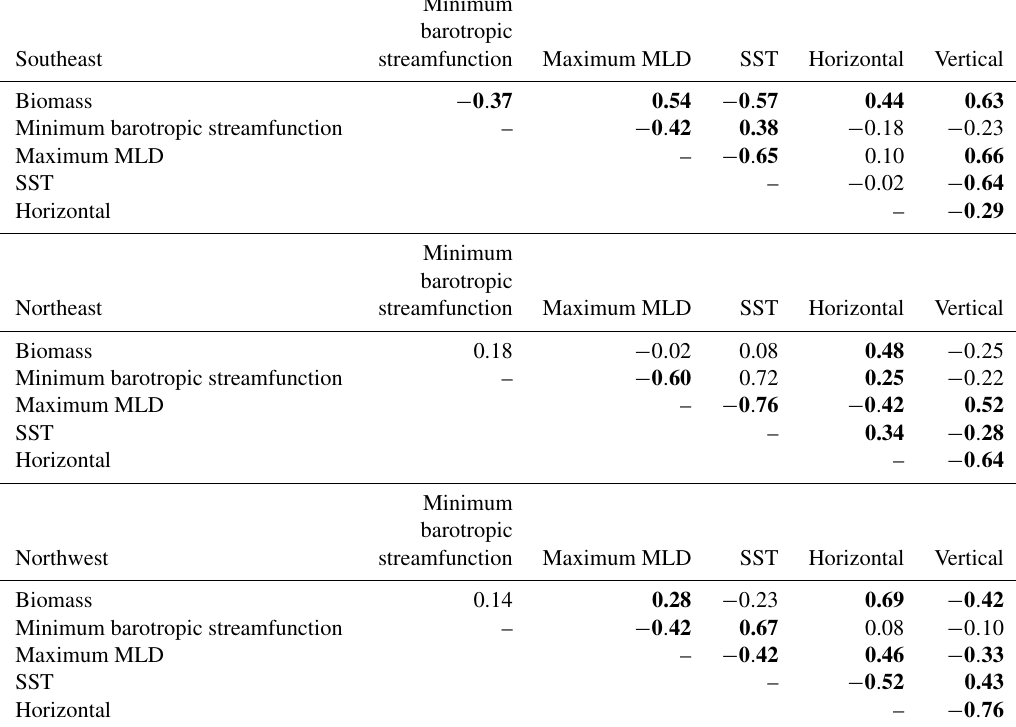
Table 2. Correlations of biomass to physical drivers and horizontal and vertical phosphate flux convergence, 1949–2009. The minimum barotropic streamfunction is found within 50–65 ◦ N, 60–30 ◦ W; maximum mixed layer depth (MLD) and sea surface temperature (SST) are area-weighted averages for each of the three averaging regions. Bold indicates statistical significance ( p< 0 . 05). Detrending is applied prior to correlation